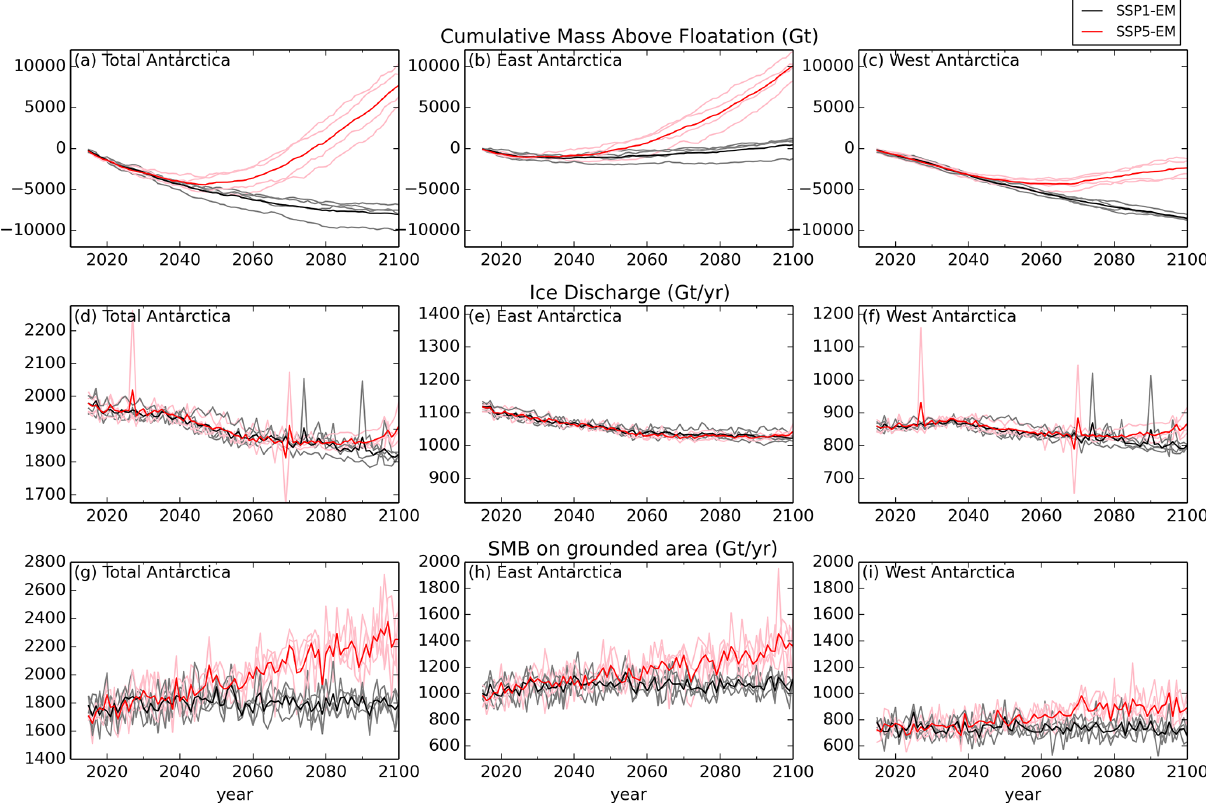
Figure 16. Time series of ice mass budget. (a–c) Cumulative anomaly of ice mass above flotation relative to the initial condition; (d–f) rate of discharge across grounding lines; (g–i) SMB rate on the grounded ice. The grey, black, pink and red lines represent the SSP1–1.9 ensemble members, SSP1–1.9 ensemble mean, SSP5–8.5 ensemble members and SSP5–8.5 ensemble mean, respectively. The Antarctic Peninsula region is considered part of West Antarctica. In each row (budget), the axis range is set the same for all columns (regions).